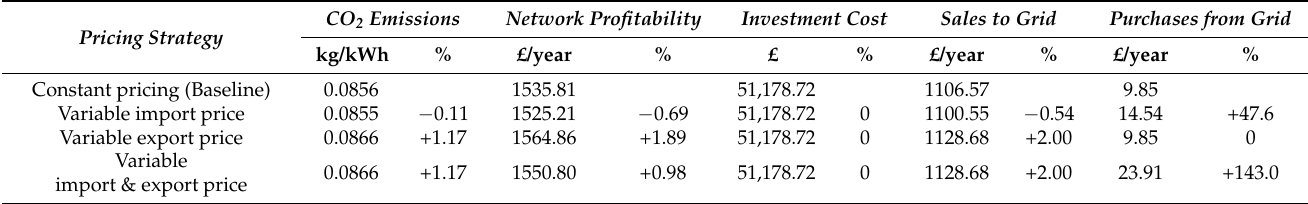
Table 7. Comparison of economic and environmental impacts for the Set network